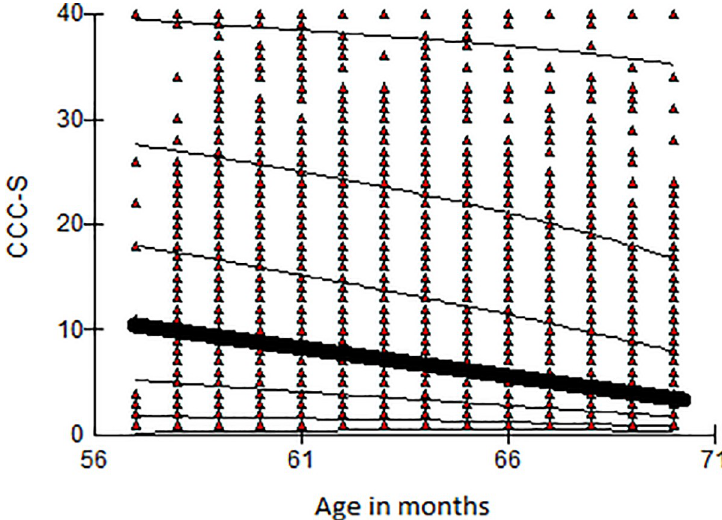
Fig 2. Centile curves for CCC-S. Centile curves for CCC-S based on the entire population (n = 6,459). The bold curve depicts the median centile values across age. The thin lines represent the 3 rd , 10 th , 25 th , 75 th , 90 th and 97 th centile curves.